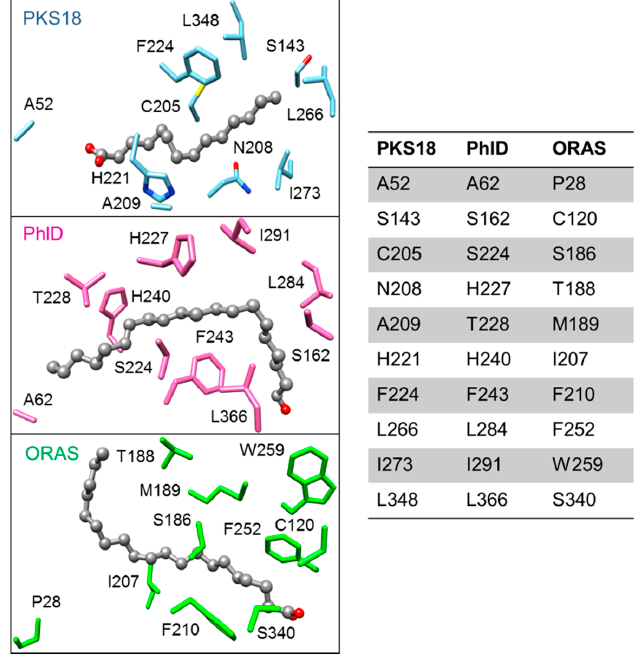
Figure 14. Acyl-binding tunnel of the following type III PKSs: M. tuberculosis PKS18 (blue, PDB